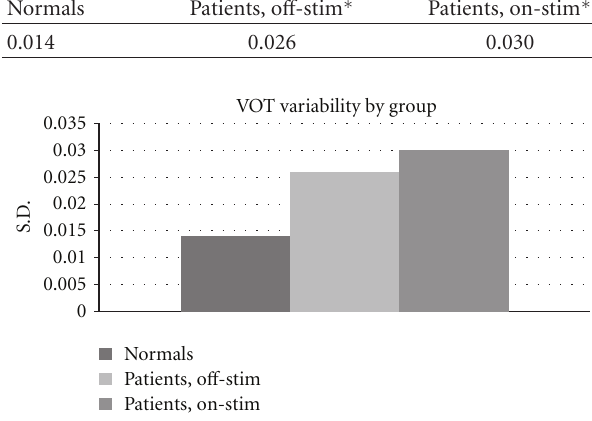
Figure 4: Voice-onset time variability across treatment condition. Normal di ff erent from patients, P ≤ . 01. Table 7: Spirantization scores by group. The mean (and s.d.) are shown for each group. ( ∗ = di ff erence from normal significant at P ≤ . 001).